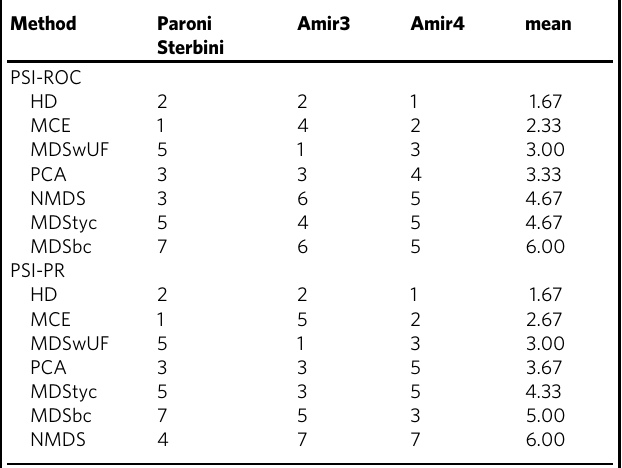
The table shows the ranked performance of unsupervised dimension reduction techniques accordingtothePSIindicesforsampleseparation(PSI-ROCandPSI-PR)inthe spaceofthe fi rst two dimensions of embedding, for the three studied datasets (Paroni Sterbini, Amir3 and Amir4). Each rank is related to the results obtained in Table 1. The results are ordered by the mean performance (fourth column) from the best (top) to the worst (bottom)